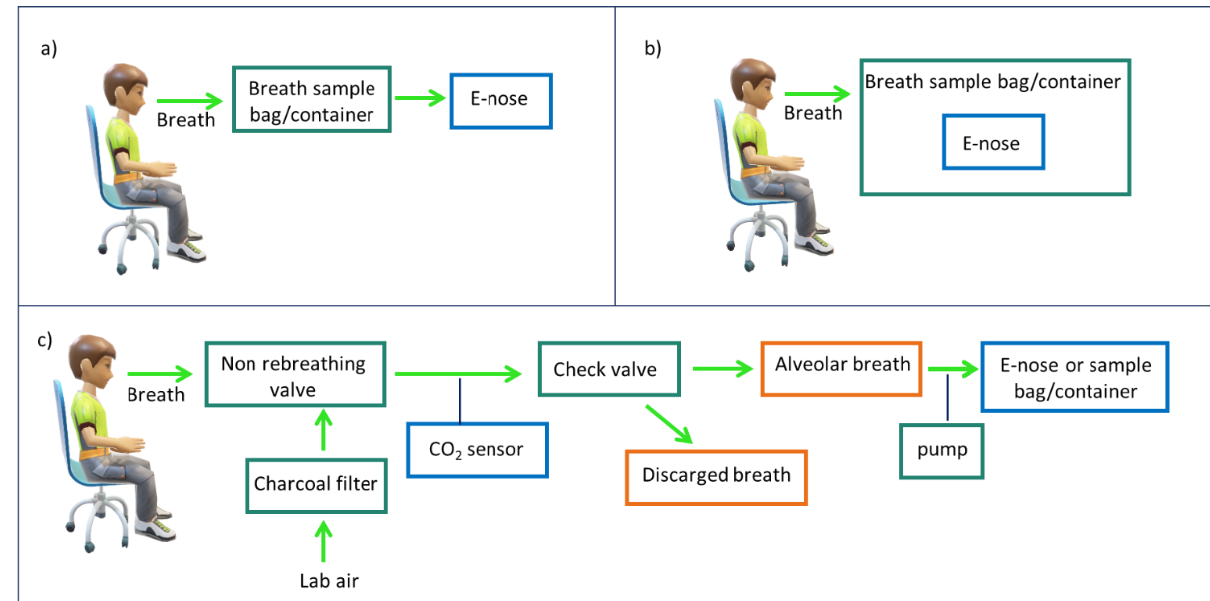
Figure 4. Schematic comparison between total breath ( a , b ) and alveolar breath ( c ) sampling. Total breath could be collected in a bag/container and then released on the electronic nose ( a ) or the electronic nose could be placed inside the container, as proposed for instance by [52] ( b ). Alveolar breath sampling requires a more complex apparatus, involving mainly a charcoal filter, a CO 2 sensor, and a pump. Alveolar breath is mainly stored in sample bags or containers but can be also fluxed directly on the e-nose, as proposed in ref [49].